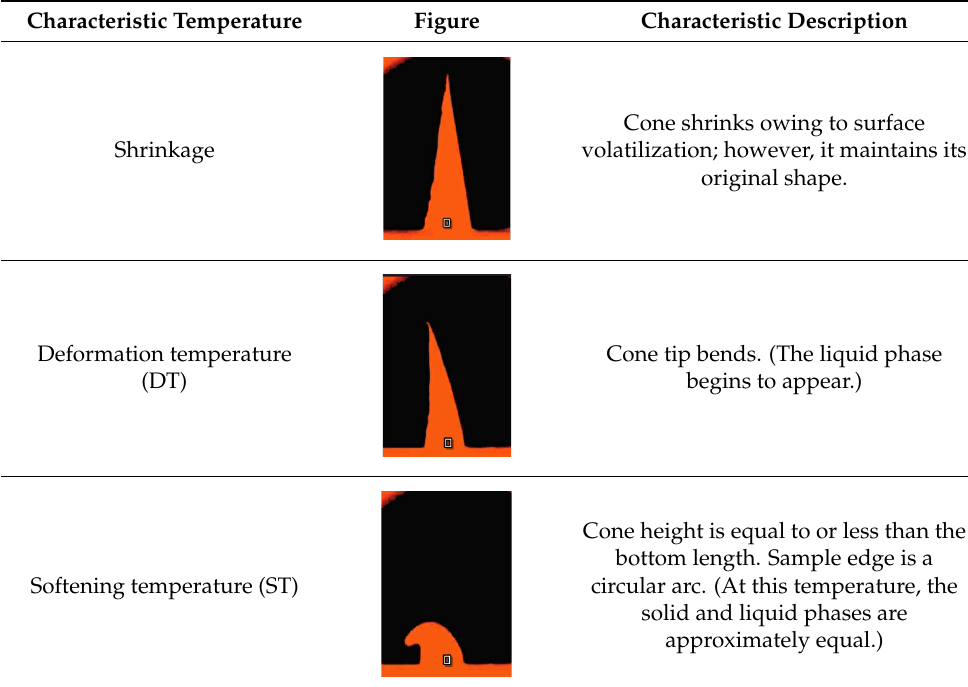
Cone height is equal to or less than the bottom length. Sample edge is a circular arc. (At this temperature, the solid and liquid phases are approximately